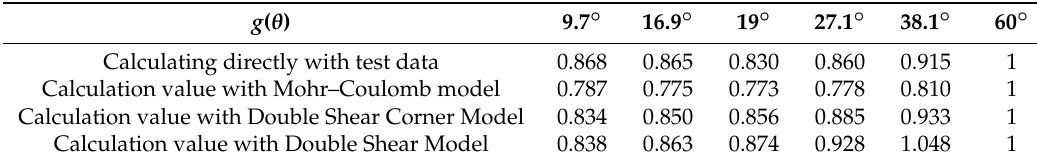
Table 5. The g ( θ ) on π plane which hydrostatic stress is 34 MPa for 5.5% cement content cement-stabilized macadam.